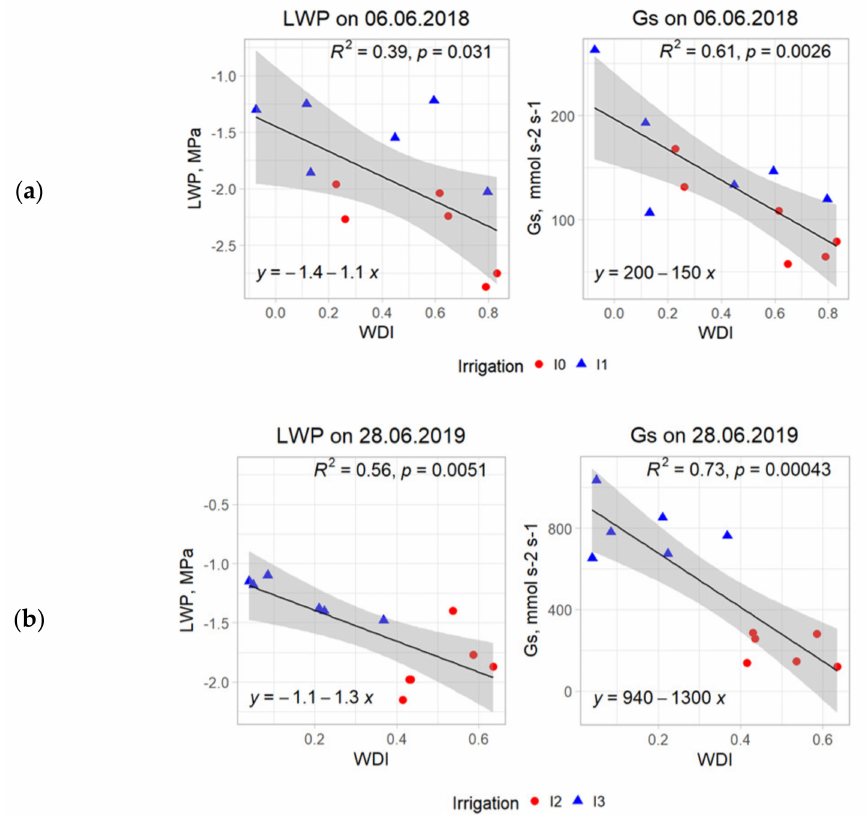
Figure 7. Correlation of the Water Deficit Index ( WDI ) with winter wheat leaf water potential ( LWP ) and stomatal conductance (g s ) on ( a ) 6 June 2018 and ( b ) 28 June 2019. I0 and I1 are minimum and optimum irrigation, respectively. I3 is a small (3 × 2 m) plot that was separately irrigated before the day of the flight on 28 June